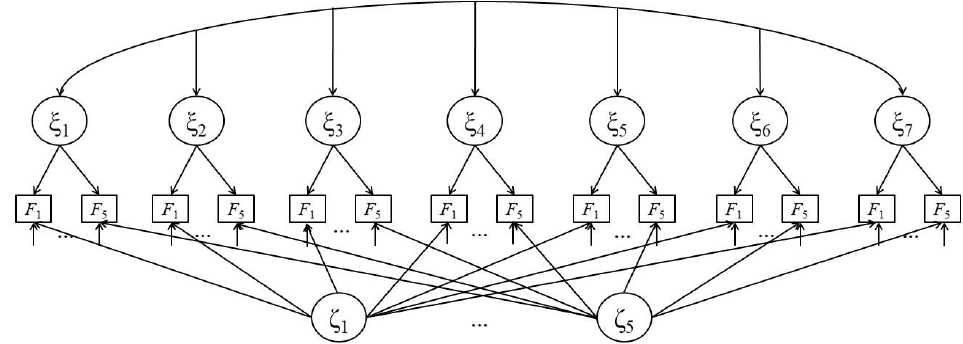
Figure 5. Situational test anxiety-confirmatory factor analysis (STA-CFA). ξ 1 – ξ 7 represent the latent STA variables measured by the fear-of-failure (FOF) items of the “Fragebogen zur Erfassung aktueller Motivation” (FAM) at every test session. F 1 represents the first item of the questionnaire and F 5 represents the fifth item. Items 2 to 4 are not shown, but are represented by the respective three dots. Loadings from latent STA variables on the manifest items can vary without any restrictions in a configural invariant model, but the loading of any item is restricted to the same respective value across test administrations when weak invariance is implemented. The free arrows approaching the manifest variables from below represent their respective error terms. Since the same items were applied in every test administration, five item-specific latent variables [93,94] were added to the model to account for indicator specific covariance. Only indicator-specific latent variables for items 1 and 5 are shown ( ζ 1 and ζ 5, respectively), but the other three are represented by the three dots in between. The model was identified by setting the factor loading of the first item for every factor to 1.